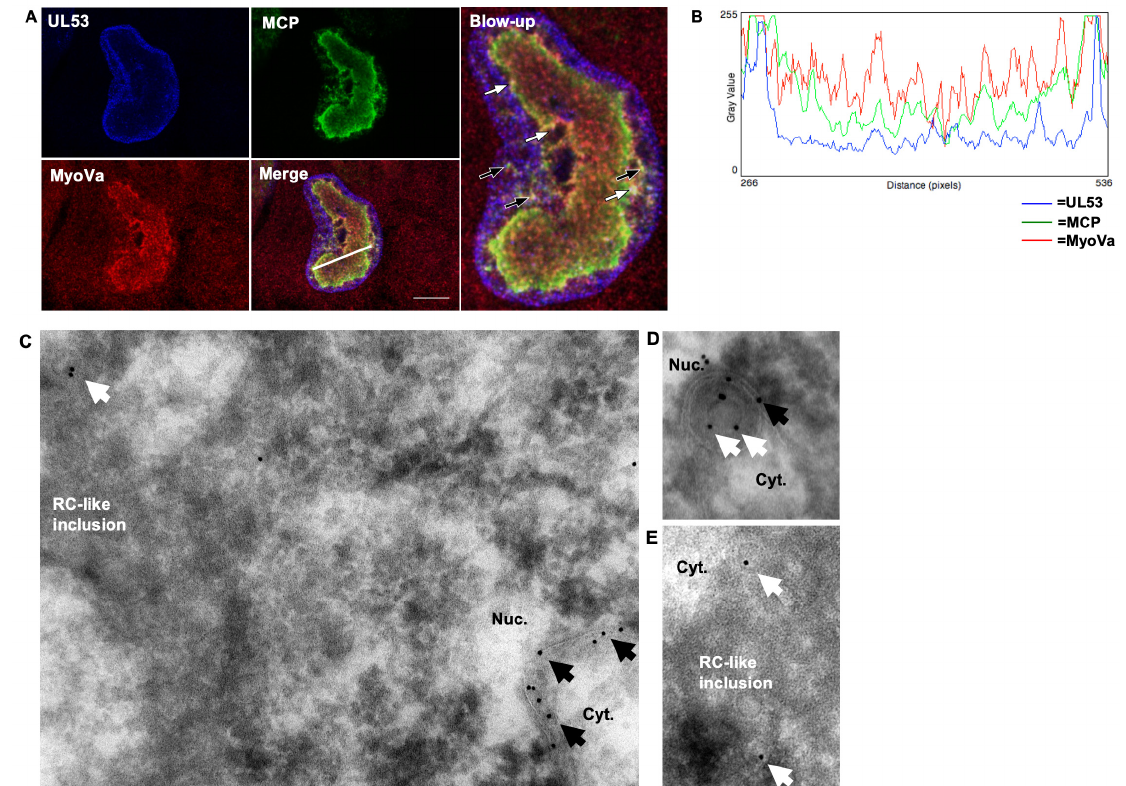
Figure 3. ( A ) HFFs were infected with 53-F HCMV (MOI 1) and fixed at 72 hpi. Cells were then stained with α -FLAG (blue), α -MCP (green), and α -myoVa (red) antibodies and imaged with spinning-disk confocal microscopy. Yellow color indicates colocalization between myosin Va (MyoVa) and MCP; purple color indicates colocalization between myosin Va and UL53; cyan color indicates colocalization between UL53 and MCP; white color and arrows indicate colocalization between UL53, MCP, and myosin Va (black arrows indicate examples of colocalization between the RC periphery and the nuclear rim; white arrows indicate examples of colocalization at the nuclear rim). Images are single optical sections. Scale bar is 10 µ m. ( B ) To measure colocalization between UL53, MCP, and myosin Va at the RC periphery, the fluorescence intensity of each channel was plotted across the indicated white line. ( C – E ) HFFs were infected with 53-F HCMV (MOI 1) and fixed for immunoEM at 72 hpi. The cells were further processed by primary staining with an α -FLAG antibody, followed by secondary staining with a 10nm protein A-gold secondary. Imaging was conducted using a transmission electron microscope. Black arrows indicate UL53 associated with the INM. White arrows indicate UL53 associated with capsids.